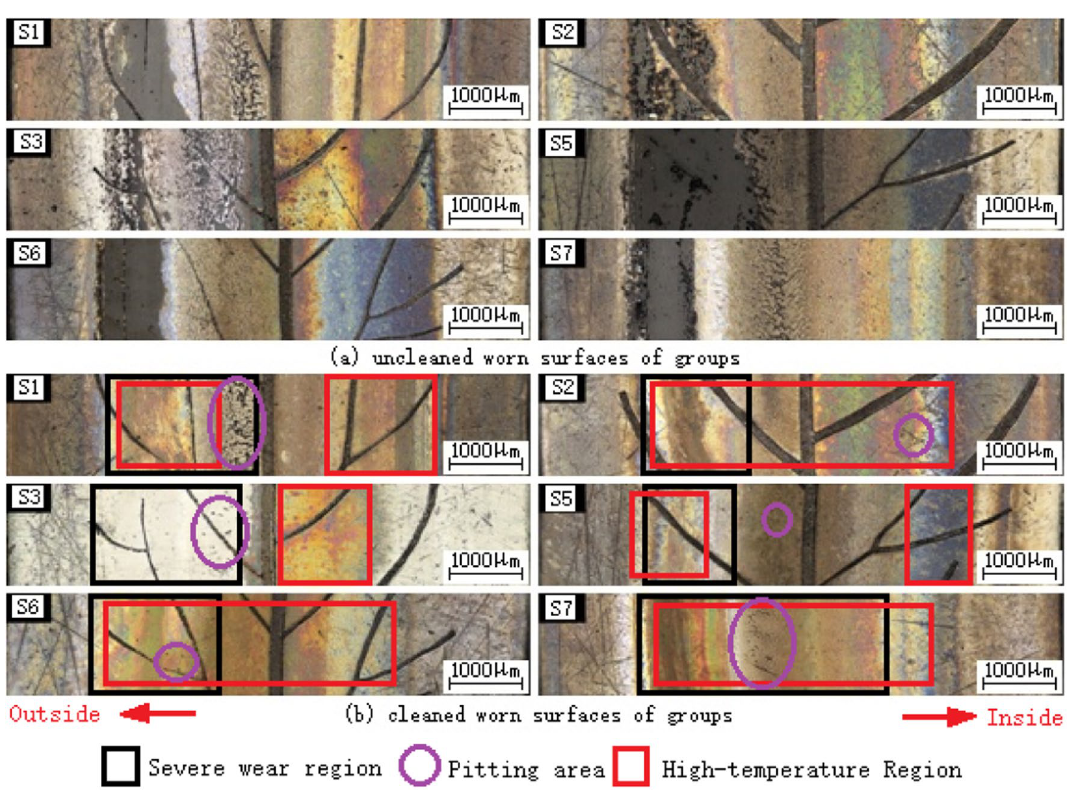
Figure 5. Worn surfaces of the shaft washers of groups (S1–S3,